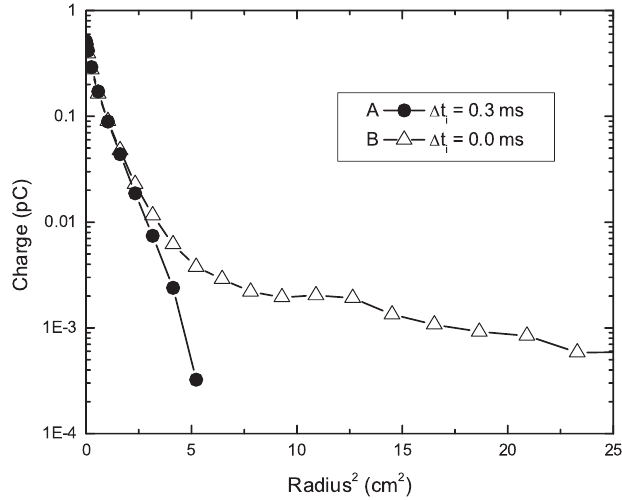
FIG. 10. Measured radial profiles of the trapped plasmas with (cid:2) 52 : 2 kHz : after minimizing the population of high-energy ! q particles (A); and with a significant population of high-energy FIG. 8. On-axis charge dependence on the total time duration particles (B). A straight line in the log versus r 2 plot indicates (cid:2) 0 : 3 ms . , for the optimum value of (cid:2) t of injection t that the radial profile is a Gaussian. i i